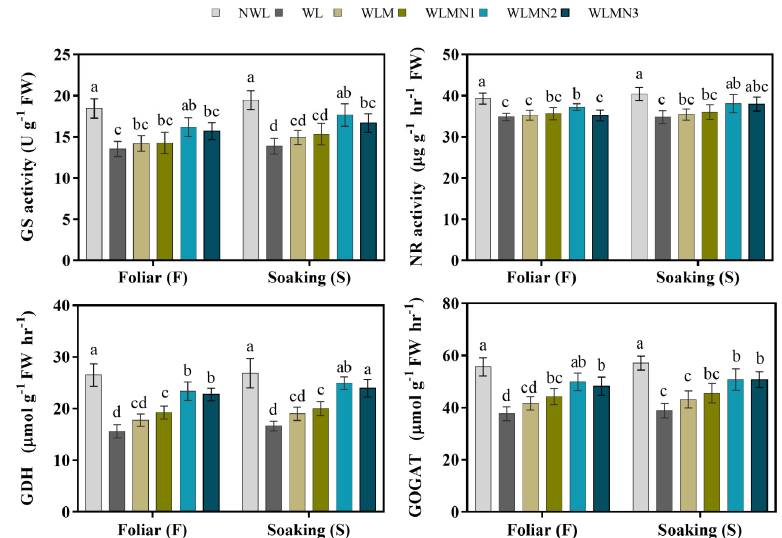
Figure 5. Nitrogen metabolism enzyme activities of maize seedlings under waterlogging stress conditions. Data are presented as mean ± SD ( n = 3, biological replicates). Different small letters (a–e) in each column indicate significant differences at p ≤ 0.05 (least significant difference (LSD) test).The abbreviations of treatment names are the same as those described in Table 2. 3.7. Effect of Nitrate on Alcohol Dehydrogenase (ADH) and Pyruvate Decarboxylase (PDC) Activities of Maize Seedlings Treated with Melatonin under Waterlogging Stress Conditions The ADH and PDC activities of maize seedlings showed the same pattern in both application methods under waterlogging stress conditions. The results showed that WL significantly increased the ADH and PDC activities compared with the NWL, WLM and treated plants (Figure 6). Foliar spray of melatonin with KNO 3 treatment WLMN2 signif- icantly reduced the ADH activity by 28.46% but was statistically similar to WLMN3, and PDC activity was reduced by 20.77% compared with WL, followed by WLMN3. Seed soaking of melatonin with KNO 3 treatment WLMN2 significantly decreased the ADH by 27.71% and PDC activity by 18.21% as compared to WL (Figure 6).